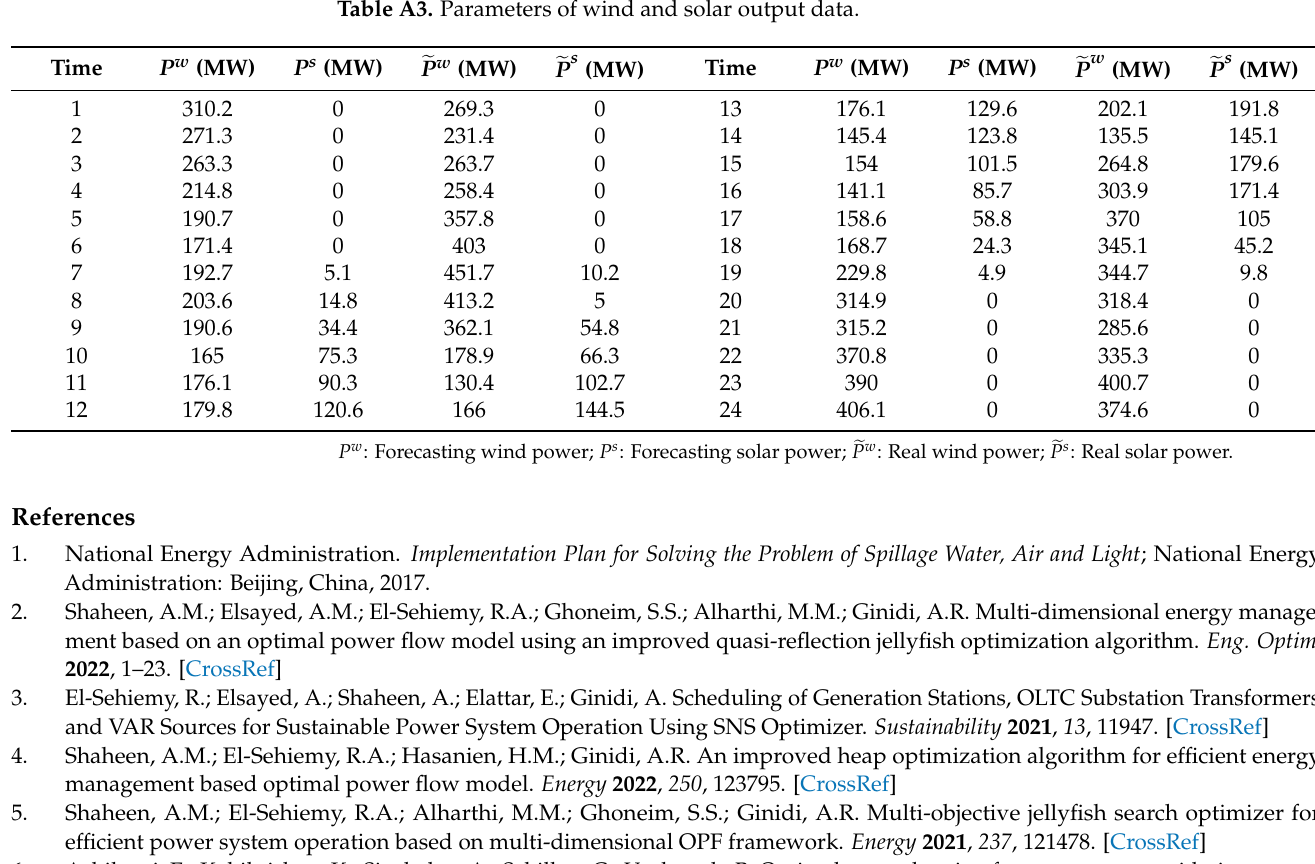
Table A3. Parameters of wind and solar output